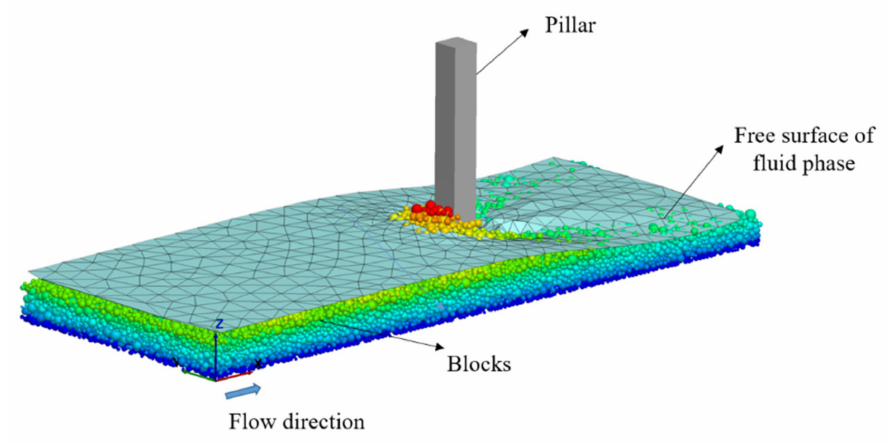
Figure 2. Example of simulation result of a DF in a linear channel with a centered pillar. Blocks are colored with respect to their vertical position. The free surface of the fluid phase, obtained in a previous CFD calculation [24], is also shown.